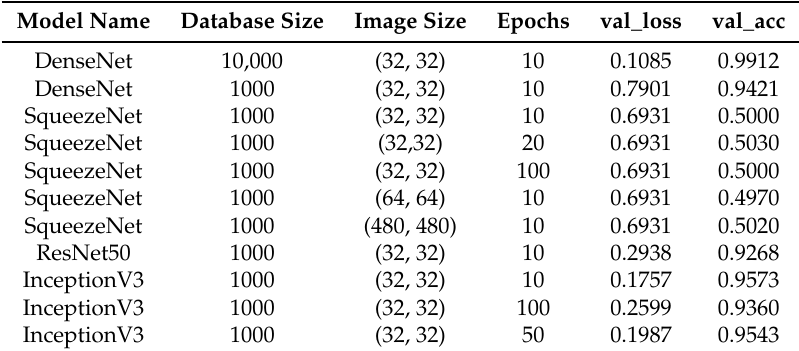
Table 4. Comparison of four pertained classification approaches for Blade and Non-Blade binary classification problem